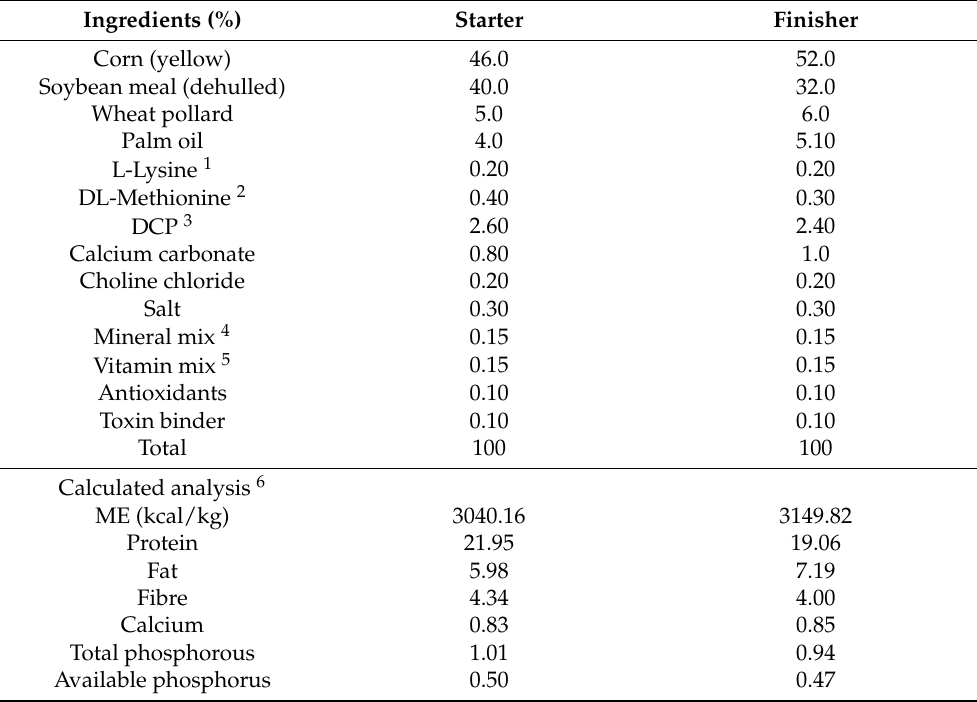
Table 1. Ingredient composition of the starter and finisher